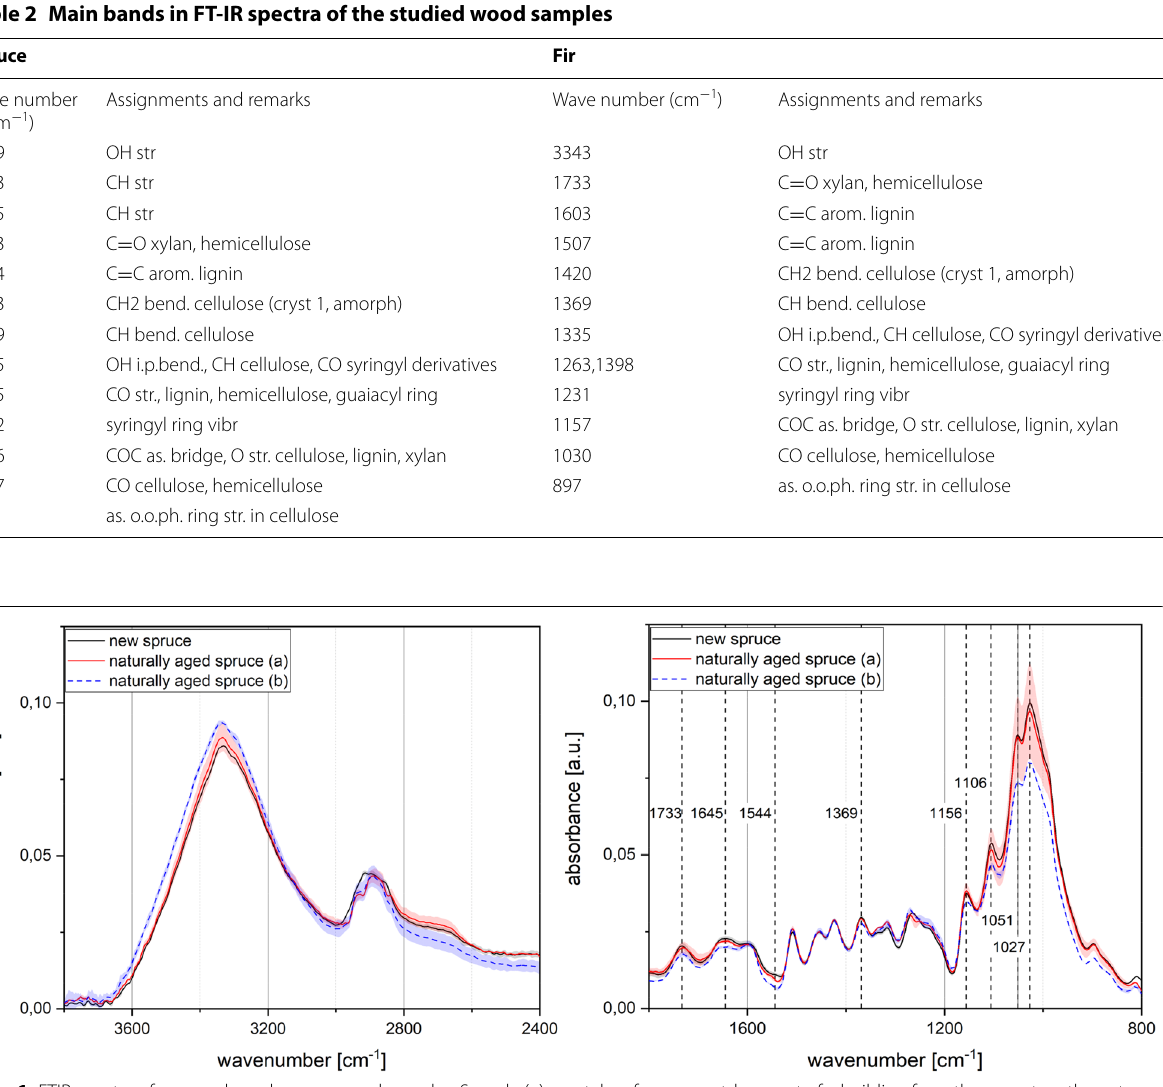
Fig. 1 FTIR spectra of new and aged spruce wood samples. Sample ( a ) was taken from an outdoor part of a building from the seventeenth century, sample ( b ) from a furniture item from the eighteenth century. The semi-transparent area around the data plot indicates the standard deviation